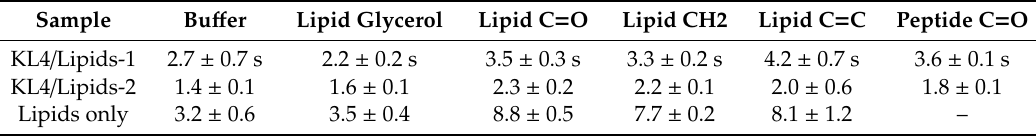
Table 2. DNP buildup times for di ff erent samples. All samples were comprised of 5.5 / 2.7 / 2 / 1 DPPC-d 62 / DPPC / POPG / cholesterol lipids reconstituted in UB, pH 7.4, containing 10 mM AMUPol and 10% DMSO. Peptide-containing samples consisted of KL 4 with a single 13 C isotope at the carbonyl